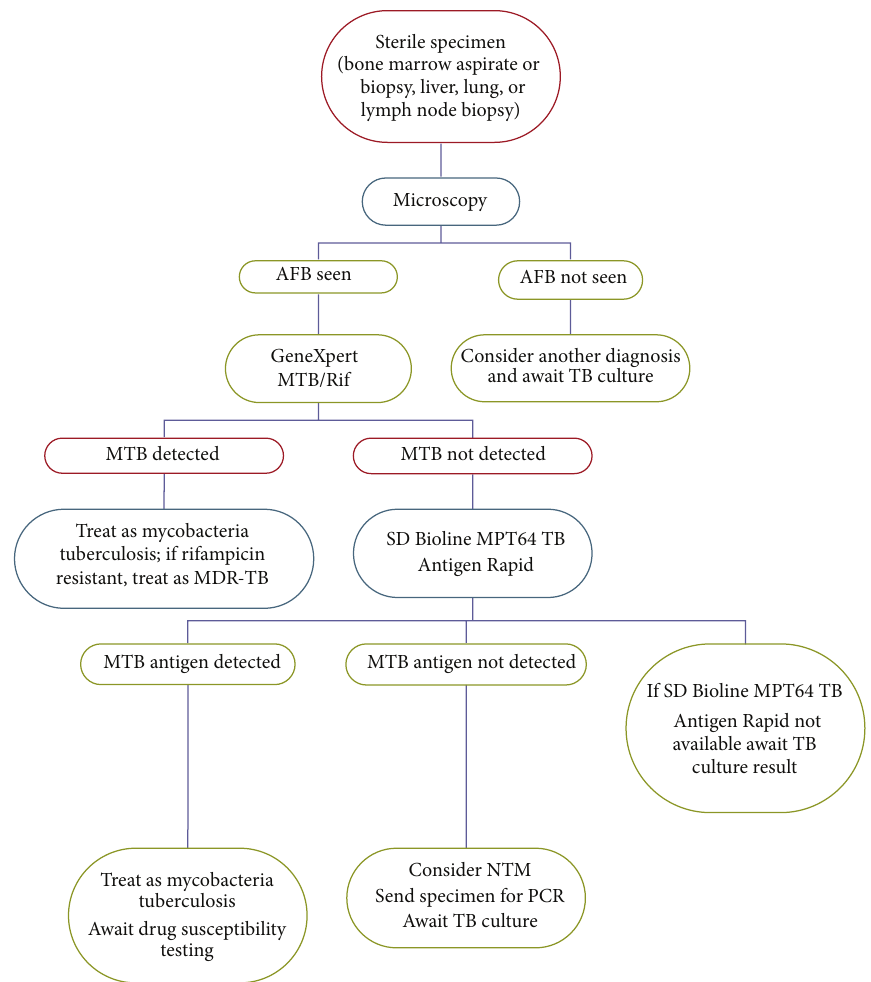
Figure 3: Proposed diagnostic algorithm for